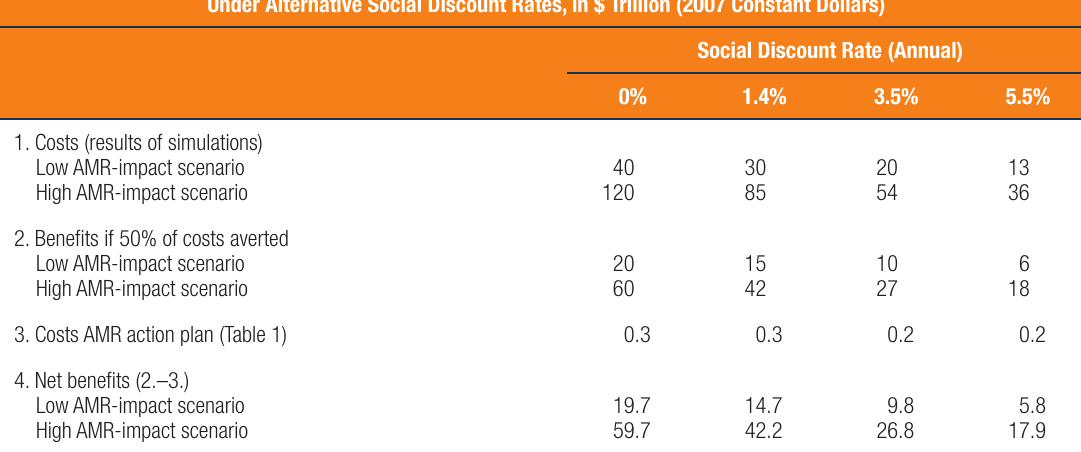
TABLE 2. Cumulative Costs of AMR, Benefits of Containment, and Costs of Measures Cumulative to 2050, Present Discounted Values